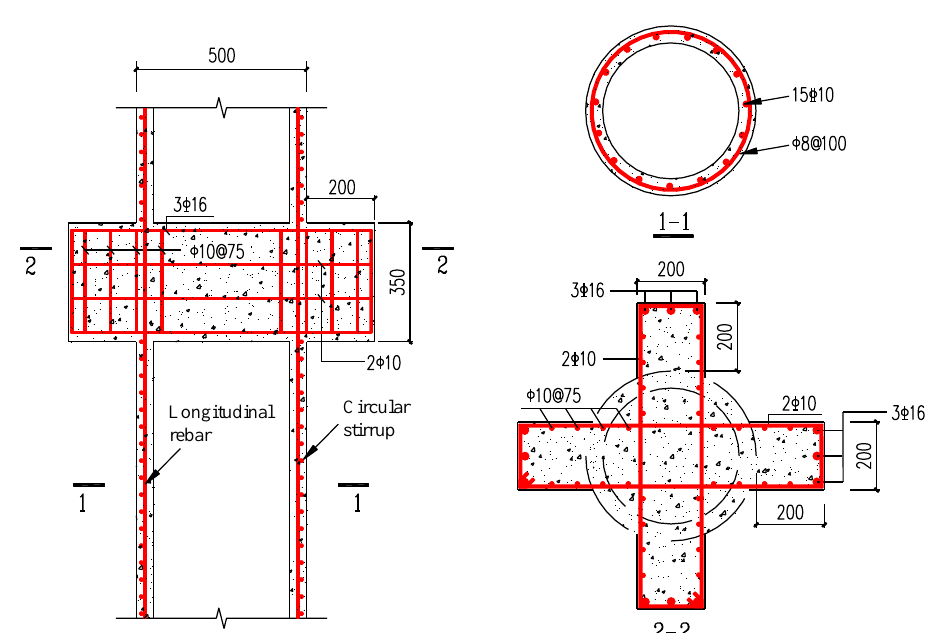
Figure 4. Steel arrangements of the RC tubular column (in mm).